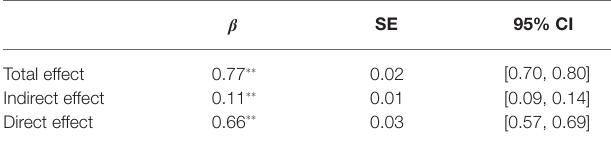
TABLE 3 | Analysis of mediating effect of SWB on PsyCap between